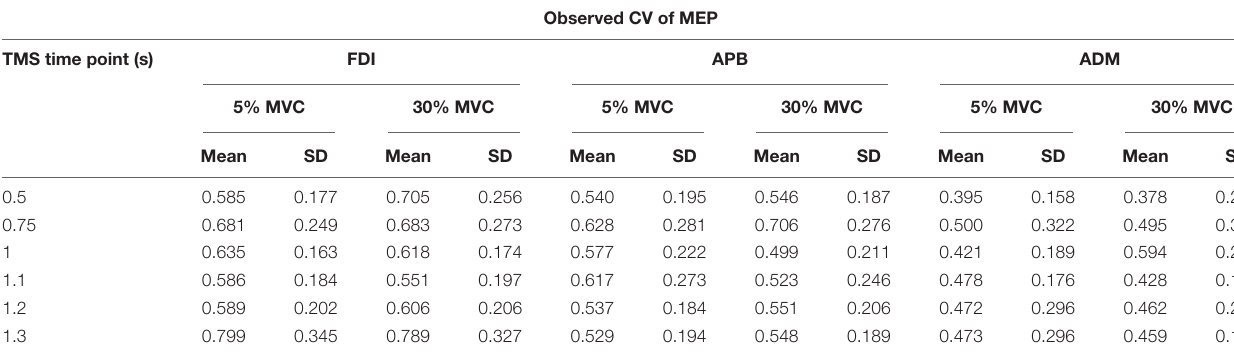
TABLE 2 | Observed CV (CV OBS ) of MEP for each TMS time point and force level.